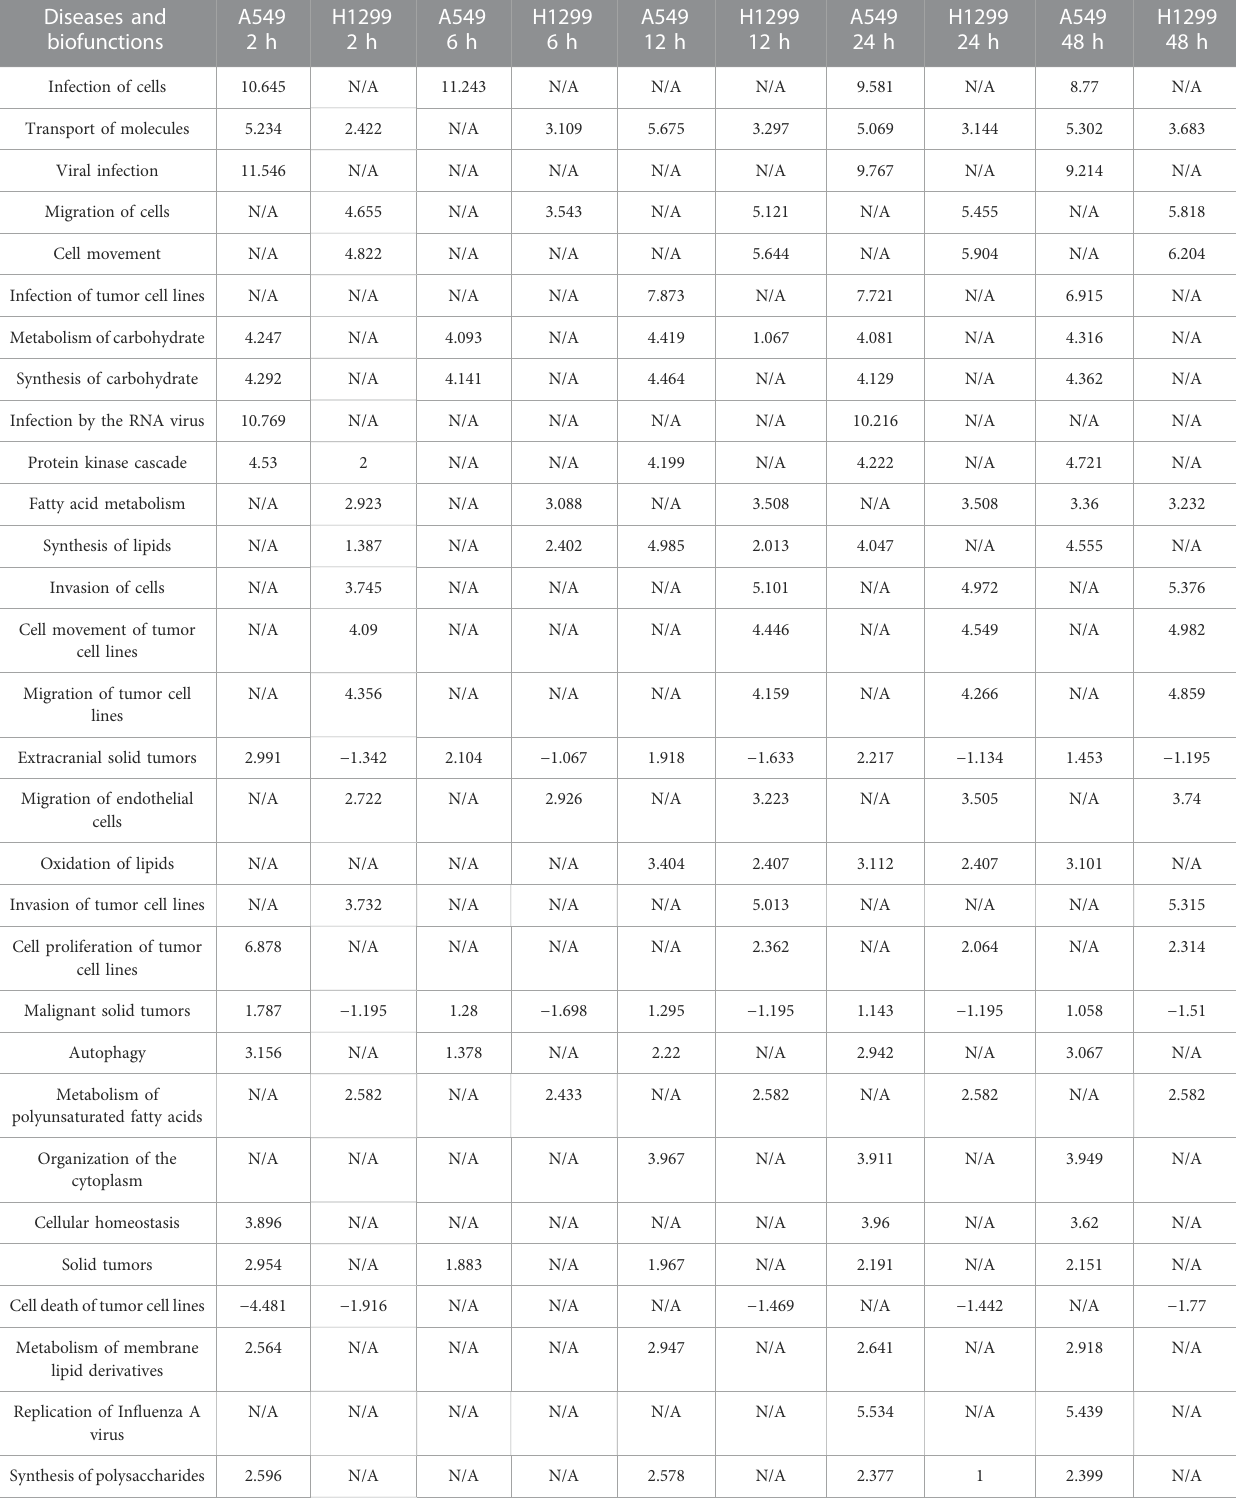
TABLE 1 Top 30 diseases and functions with the most signi fi cant changes at fi ve time points (2, 6, 12, 24, and 48 h) after radiation in NSCLC. Diseases and biofunctions